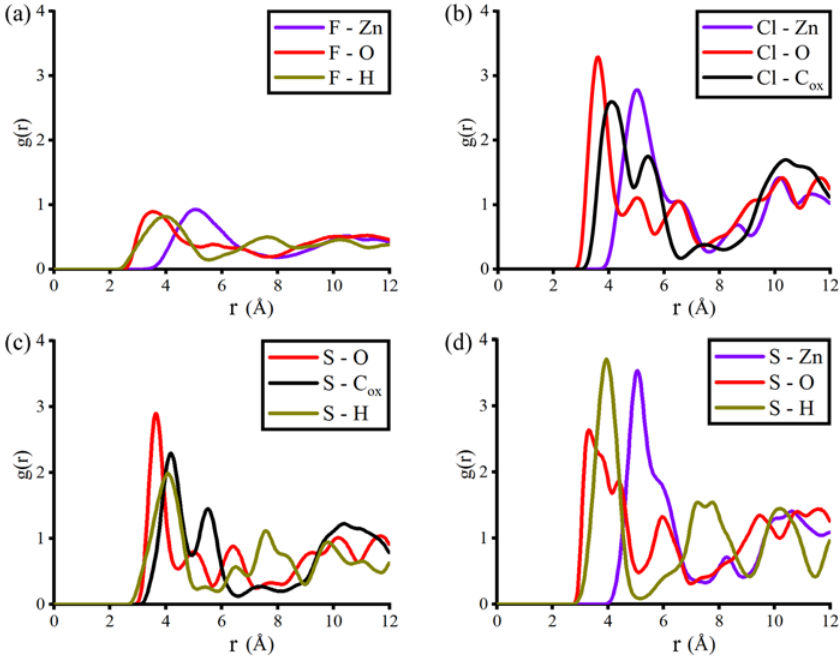
Figure 4. Radial distribution plots for ( a ) F 2 , ( b ) Cl 2 , ( c ) H 2 S, and ( d ) SO 2 gases in CALF-20.